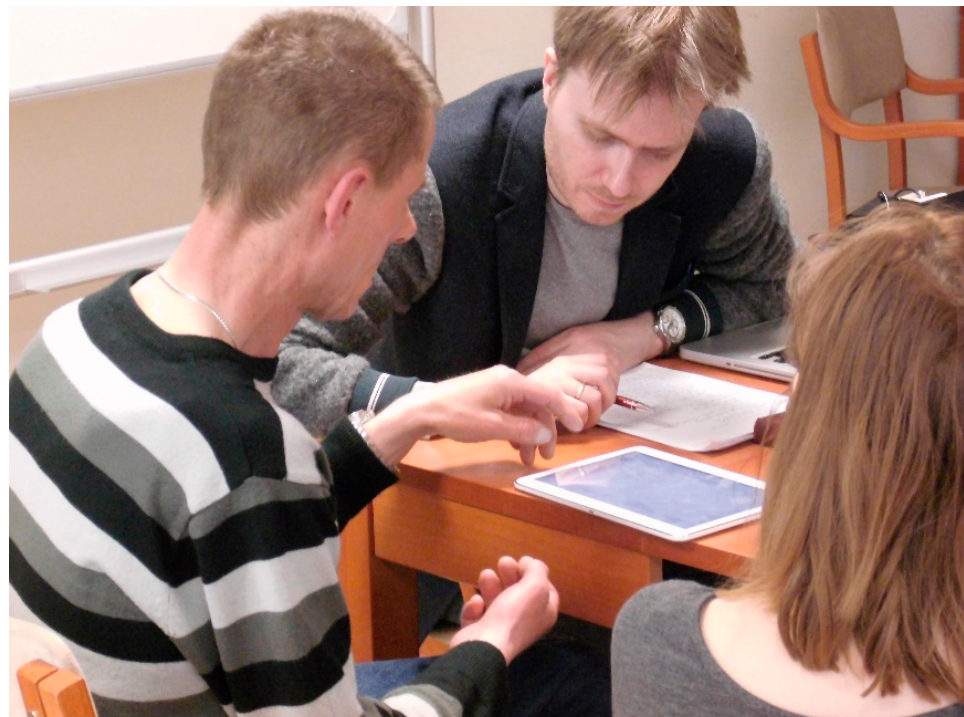
Figure 12. User tests with people with aphasia in Pozna ń .